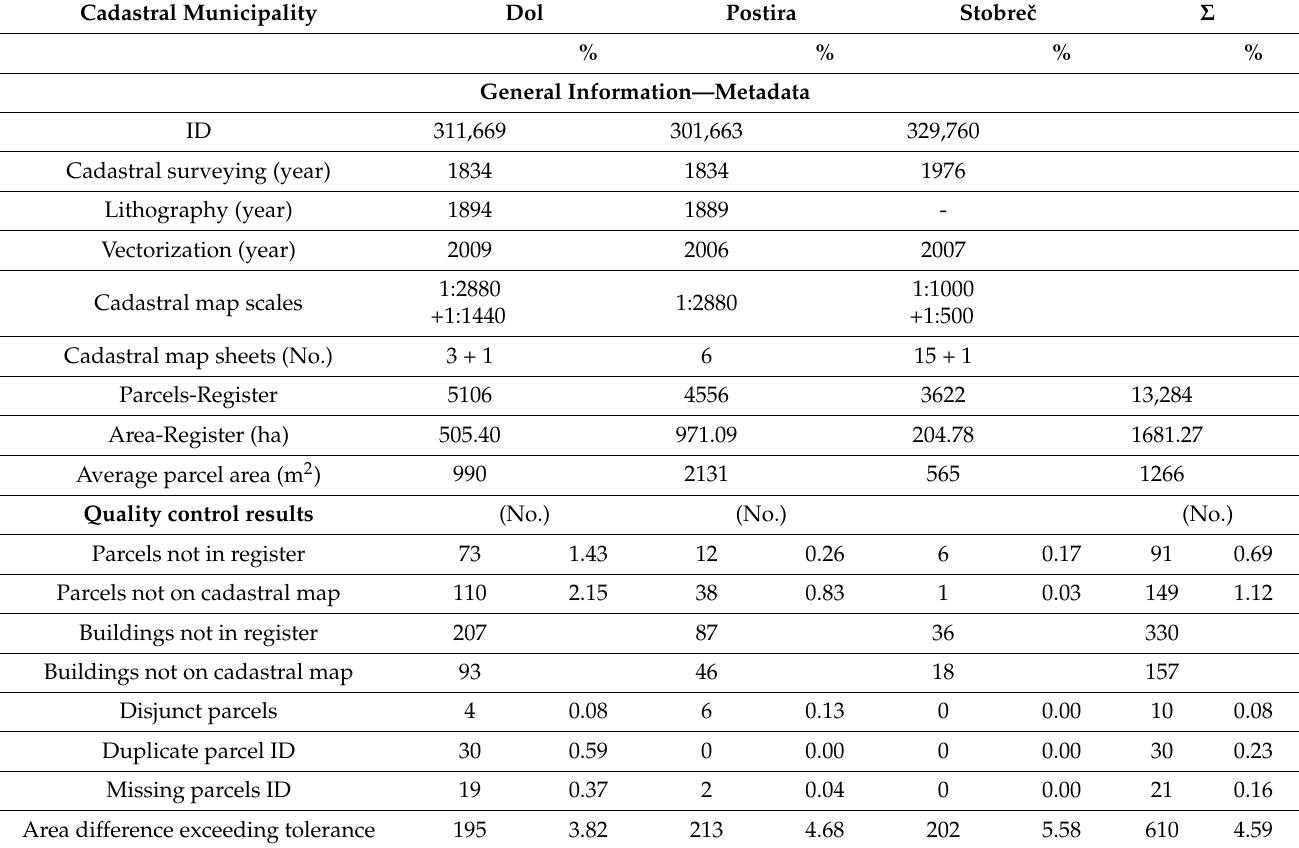
Table 1. Summary data of the research areas and vectorization quality control results. Cadastral Municipality